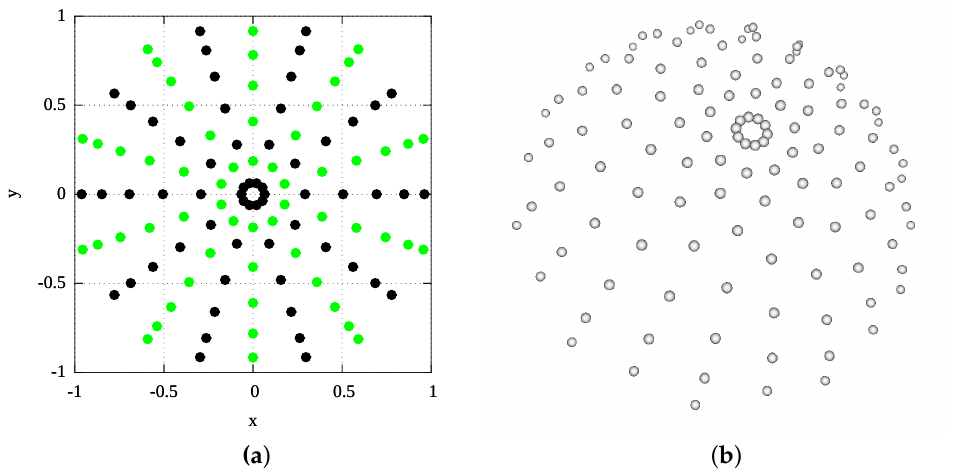
Figure 18. Visualization of 120 camera positions used for BTF data acquisition for 1020 s duration. ( a ) In XY projection from unit hemisphere The black dots represent camera positions for rotating servo motor clockwise, the green dots for rotating the geared servo motor anticlockwise; ( b ) 3D perspective visualization of camera positions as